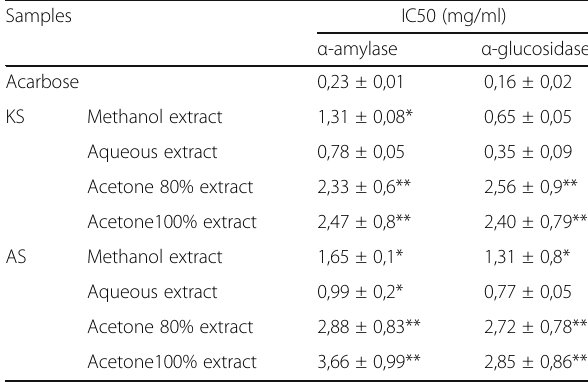
Table 3 IC50 of α -amylase and α -glucosidase inhibition